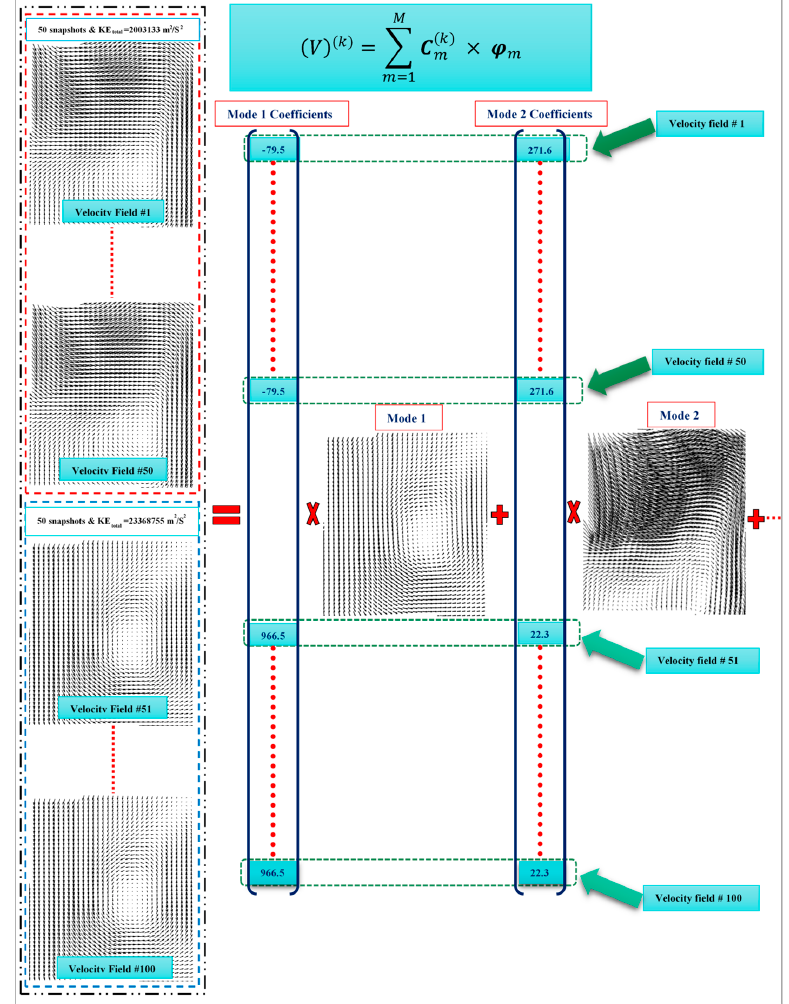
Figure 7. Illustration of POD for capturing of coherent structures.